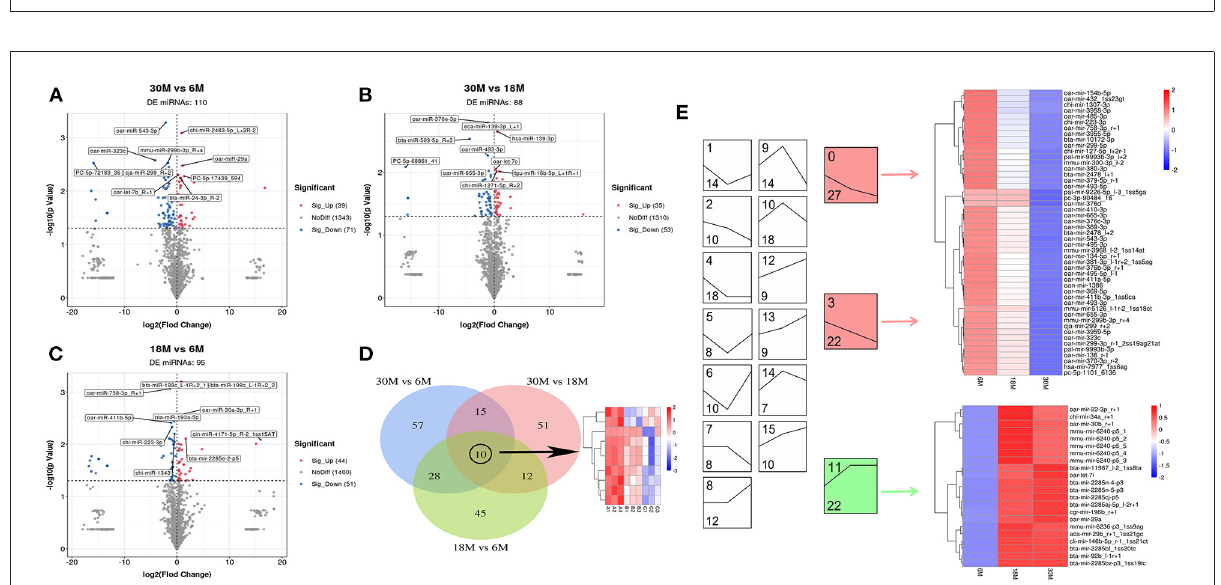
FIGURE2 miRNA differential expression analysis. (A–C) The volcano plot of DE miRNA. (A) 30M vs. 6M; (B) 30M vs. 18M; (C) 18M vs. 6M. Annotated as the top five DE miRNA based on P -value. (D) Venn diagram analysis of DE miRNA. (E) Expression trend analysis of DE miRNA. The upper number indicates the ordinal number of each trend, while the lower number is the number of genes enriched, and those with color are the significantly enriched